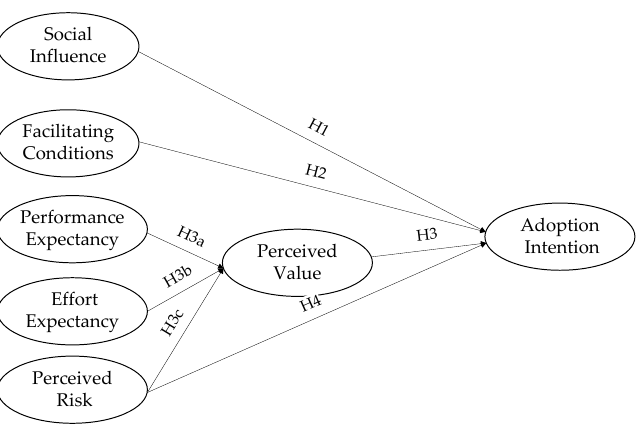
Figure 1. FinTech adoption model.